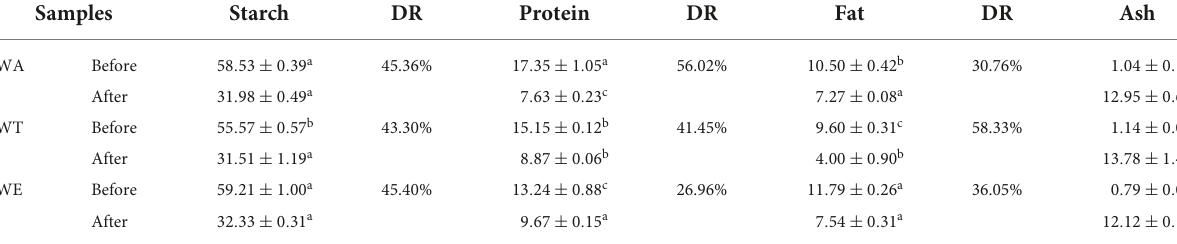
TABLE 2 Changes of starch, protein, fat and ash content in each group before and after in vitro digestion (g/100 g). Samples